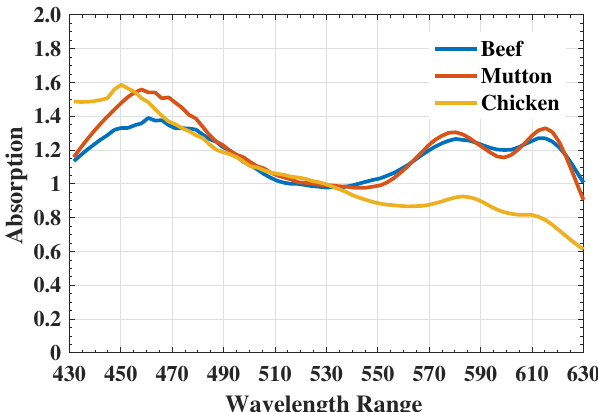
Figure 4. A single point Mb-based spectral features spectrum for each meat class. Soret absorption band (430-450 nm), meta-Mb (500–515 nm), dexa-Mb (545–560 nm), oxa-Mb (580–610